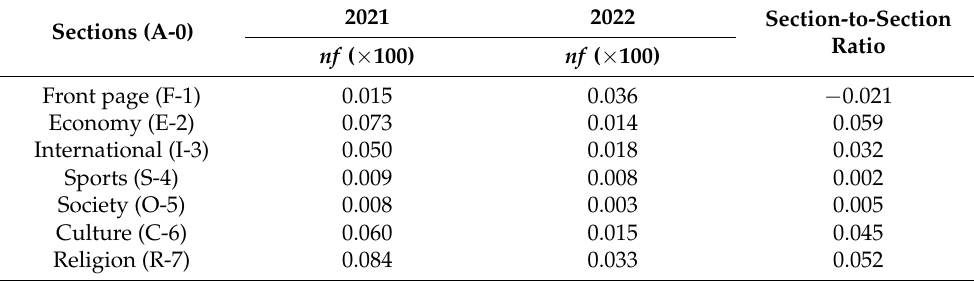
Table 6. Corpus-to-corpus (section-to-section) ratio for the 2021 and 2022 samples. Sections (A-0)